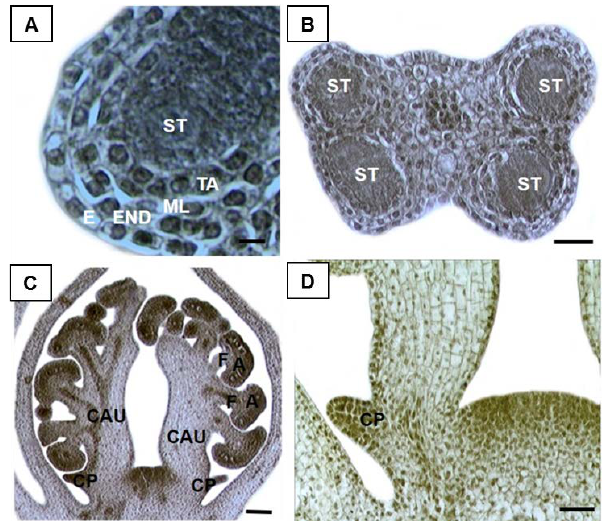
Fig. 4. Stage 5: Anther wall layers and sporogenous tissue formation (A, B) and Stage 6: Corolla initiation (C, D). A. Proper anther wall layers and sporogenous tissue.